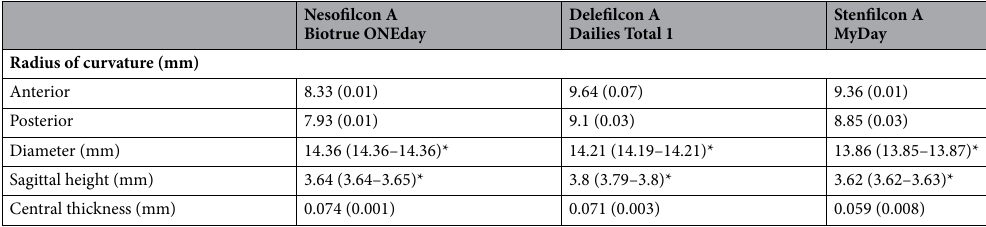
Table 3. Repeatability of measurements of the central radii of central curvature, diameter, sagittal height, and central thickness from new daily disposable soft contact lenses; mean values (standard deviation, SD). *Median (range).